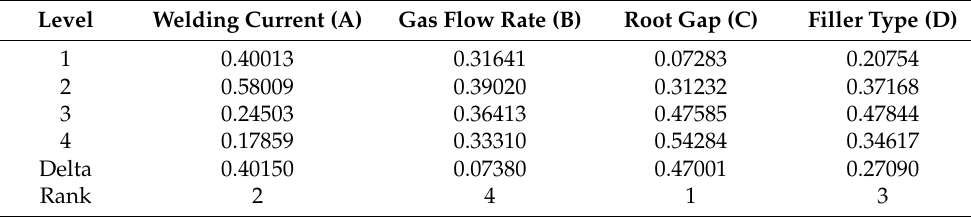
Table 26. Response table for means (CDI).